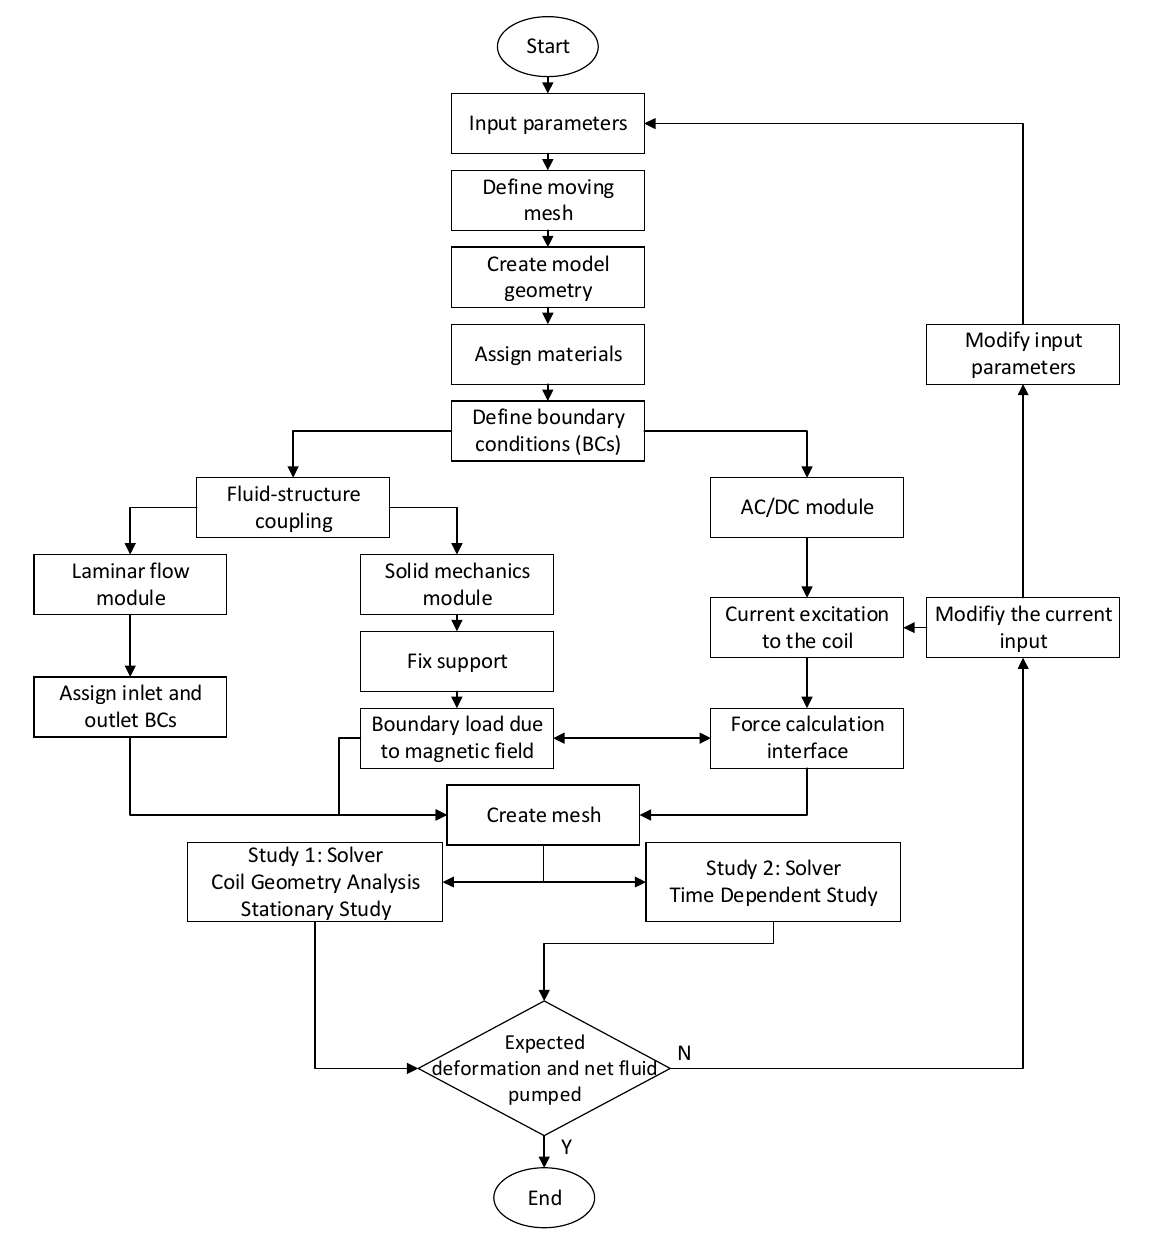
Figure 5. Flowchart of the simulation process in COMSOL.